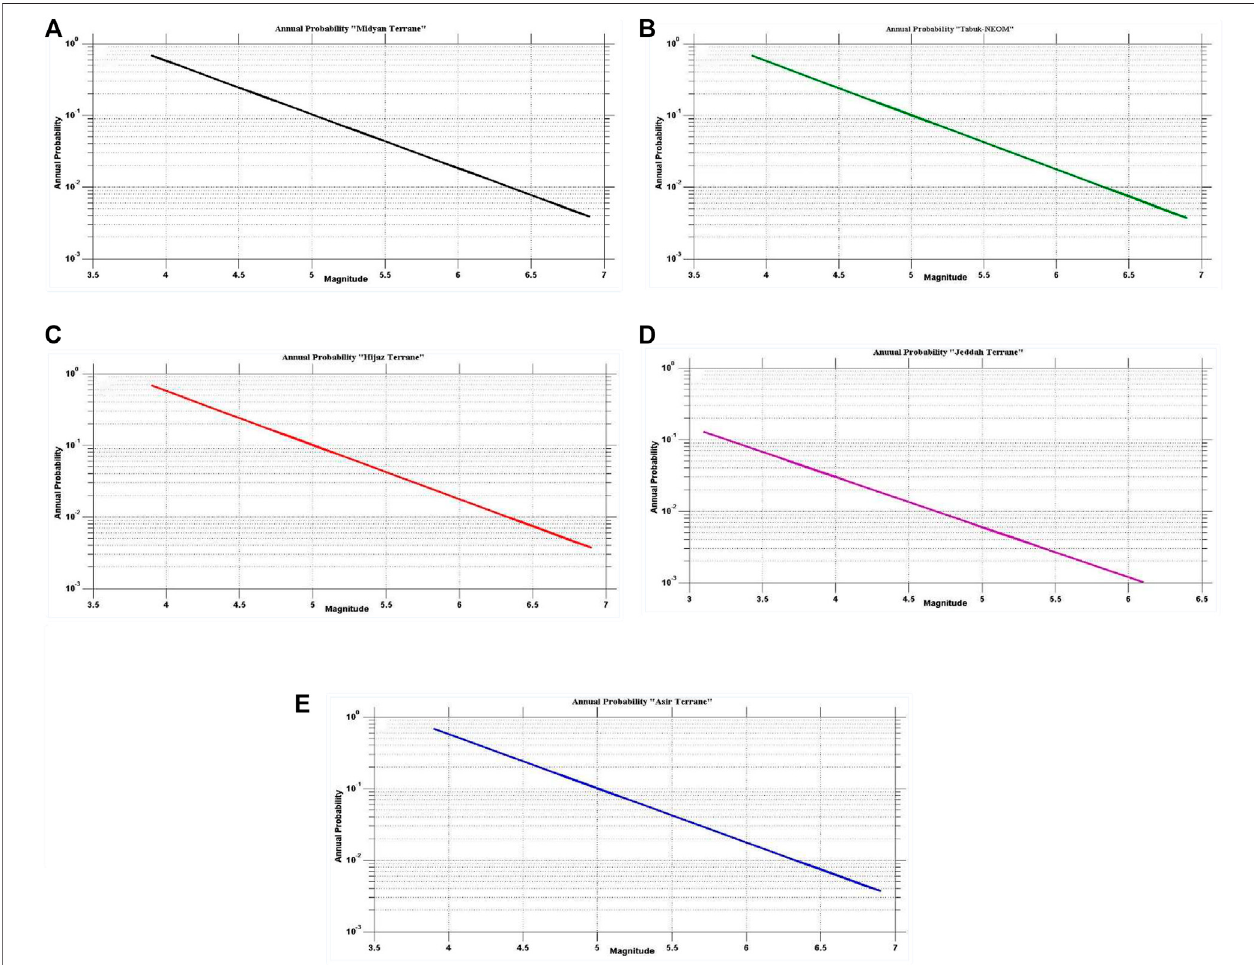
FIGURE 13 | (A – E) Annual probabilities of the earthquake activities in various levels of magnitude for the studied regions as represented by the color legend.